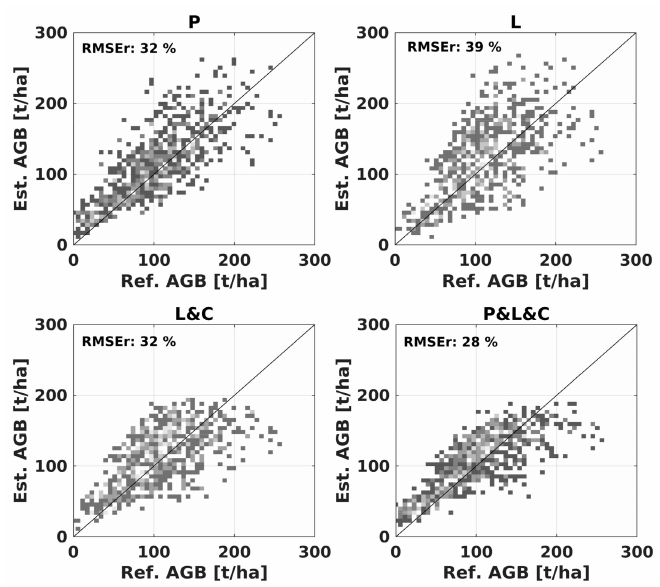
Figure 10. Comparison of LiDAR-derived above-ground biomass (AGB) estimates with estimates obtained with di ff erent combinations of multi-temporal C-, L-, and P-band backscatter at the one-hectare